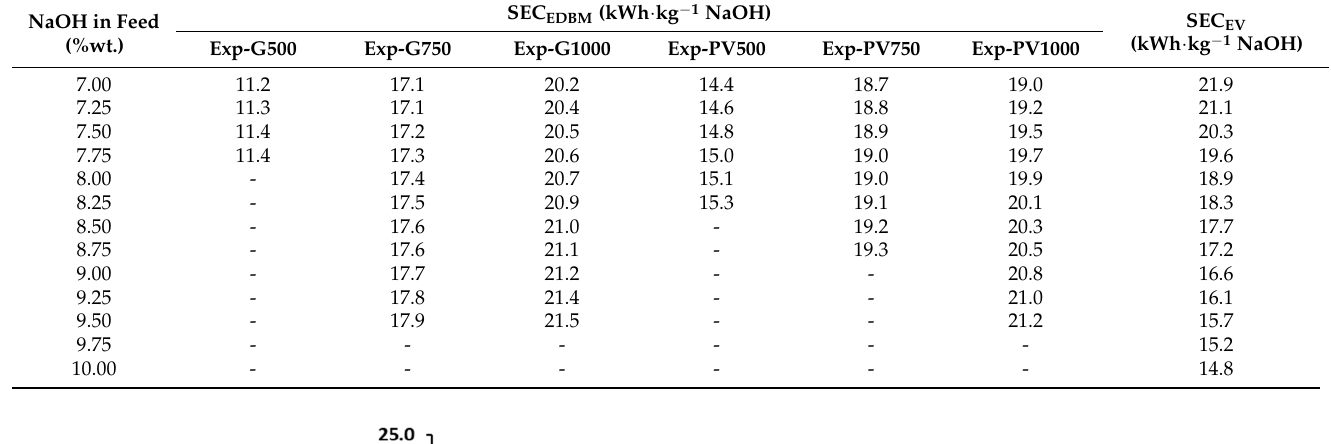
Table 2. SEC EDBM and the SEC EV for different NaOH concentrations in the feed of the evaporation system for a target final concentration of 50%wt. NaOH. NaOH in Feed (%wt.)